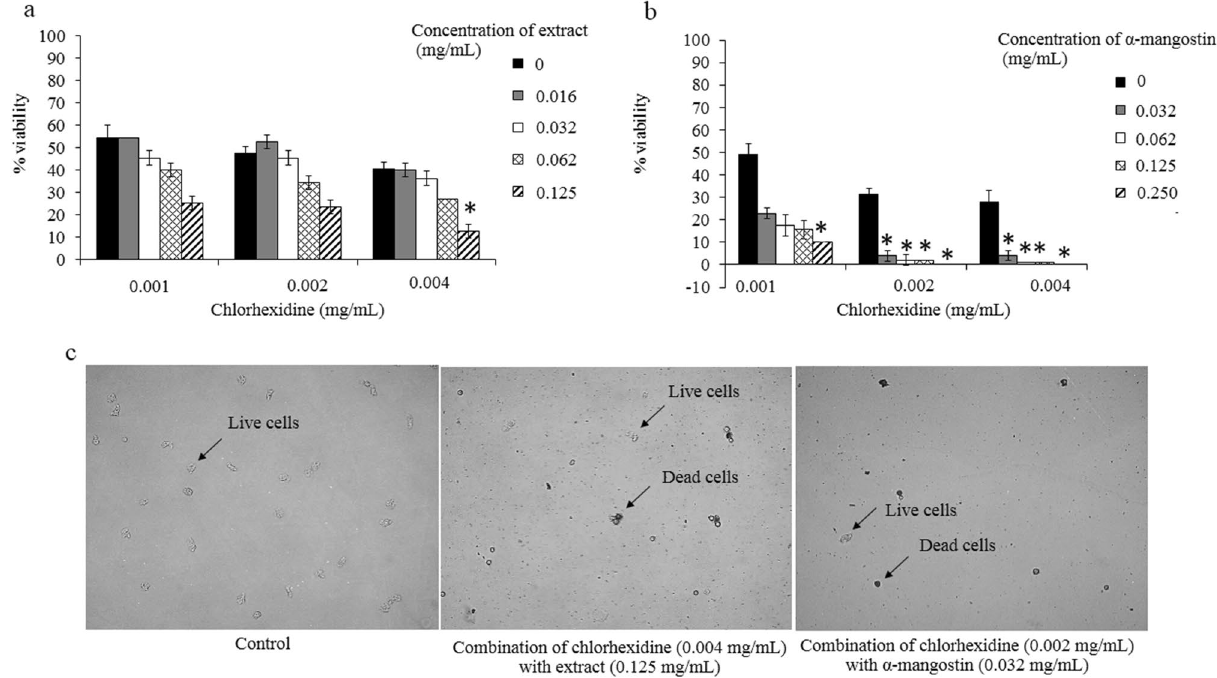
Figure 4. Combination of G. mangostana extract or α-mangostin with chlorhexidine for anti-amoebic effects on trophozoites of A. triangularis. Parasites were grown in PYG medium in the presence of chlorhexidine alone and combination with G. mangostana extract ( a ) or α-mangostin ( b ) for 24 h. The inhibitory activity was carried out using trypan blue exclusion assay; 1% DMSO was used as negative control ( c ). Treated trophozoites were observed under inverted microscopy (20x). The relative percentage of viability was defined as (mean of the treated /mean of the control) × 100. * p < 0.05, statistically significant difference in combination to single drug